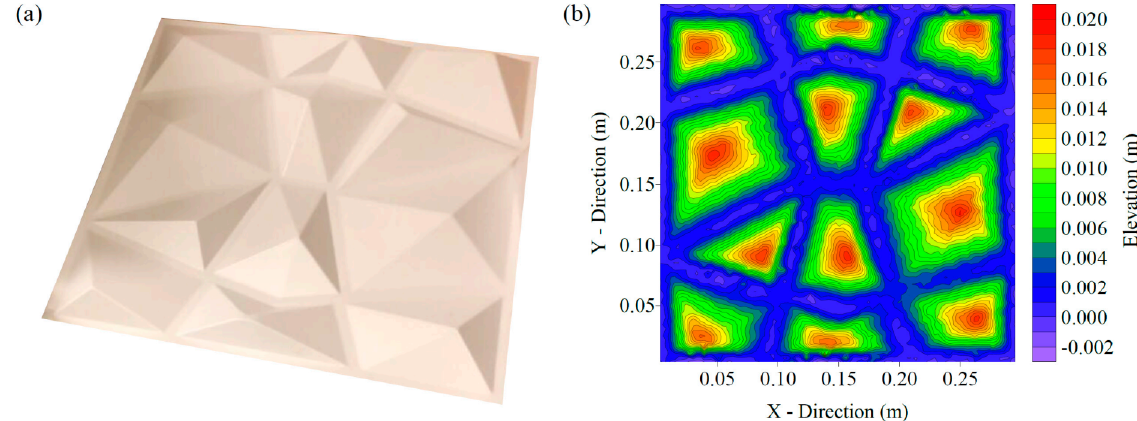
Figure 4. Rough ice cover: ( a ) individual panel, and ( b ) contour plot of the surface elevation of an individual